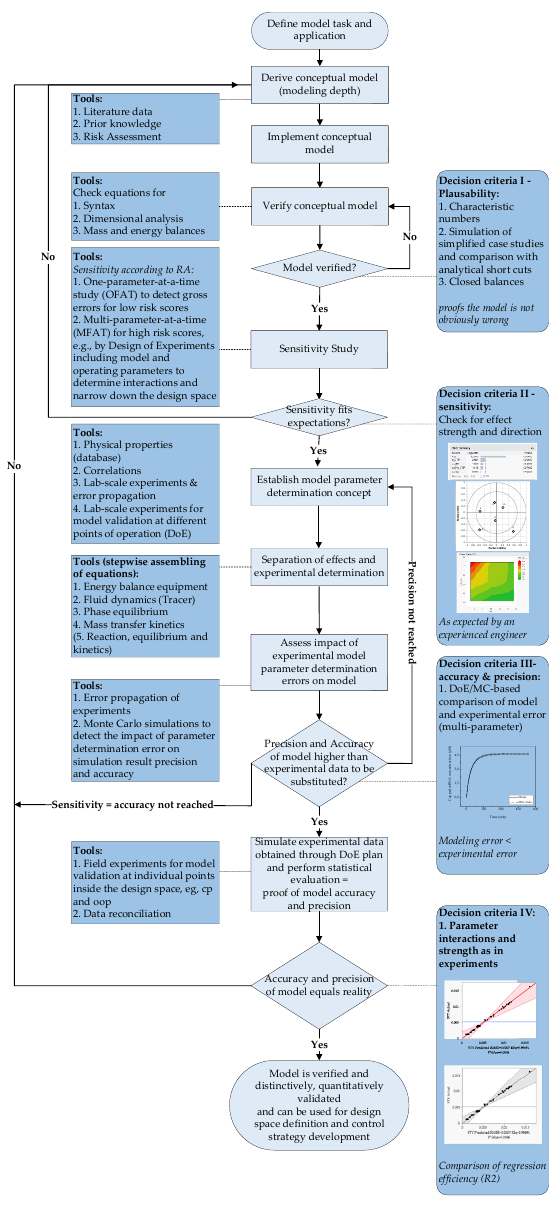
Figure 3. Decision tree for a process model validation according to Sixt et al. Applying this workflow allows a quantitative evaluation of the model quality based on mechanistic and statistical decision criteria. A rigorous execution of the procedure leads to a distinctively and quantitatively validated rigorous process model [39,40].